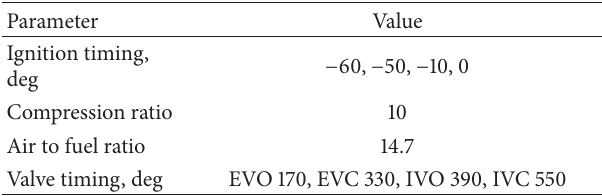
Table 5: Input parameters for varying ignition timing